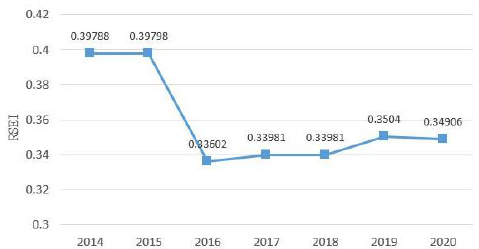
Figure 3. RSEI map of Shanxi Province for winter 2013- 2019